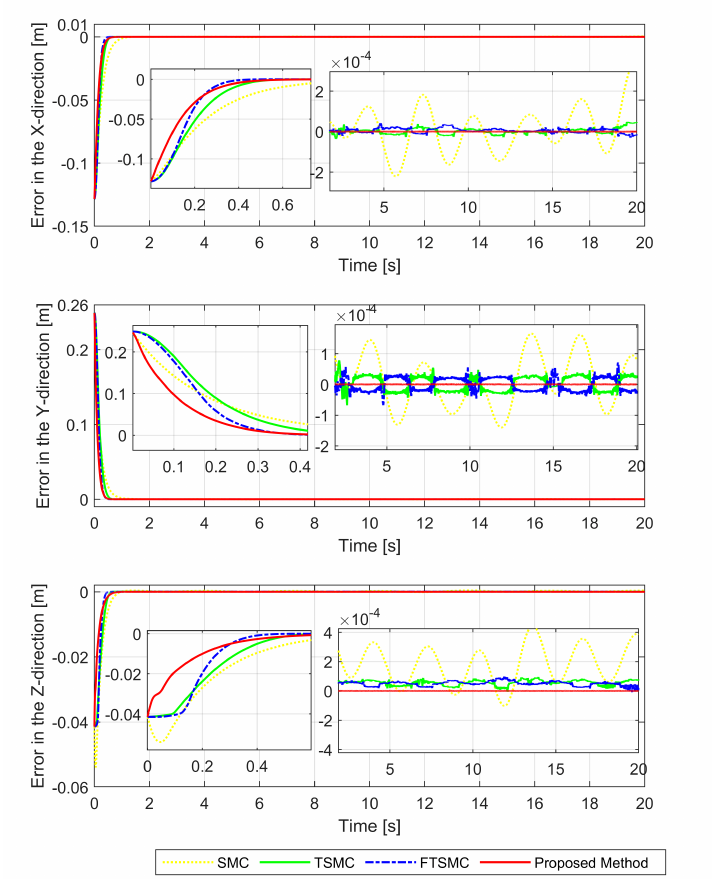
Figure 10. X-axis, Y-axis, and Z-axis error comparisons between the position of the end effector and the reference